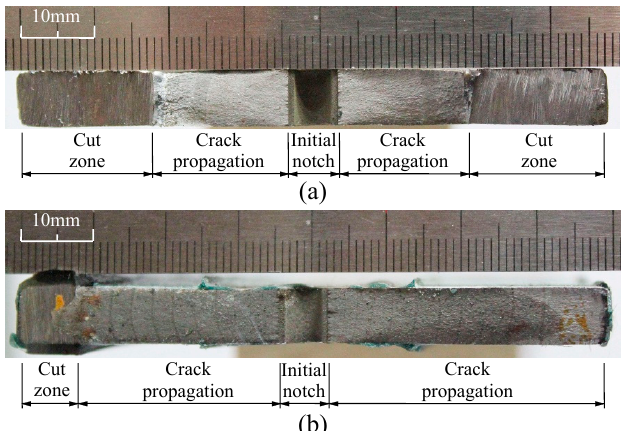
Figure 8. (a) Fracture surface of specimen U-2 (along Crack 2); (b) Fracture surface of specimen ND-1 (along Crack 2).